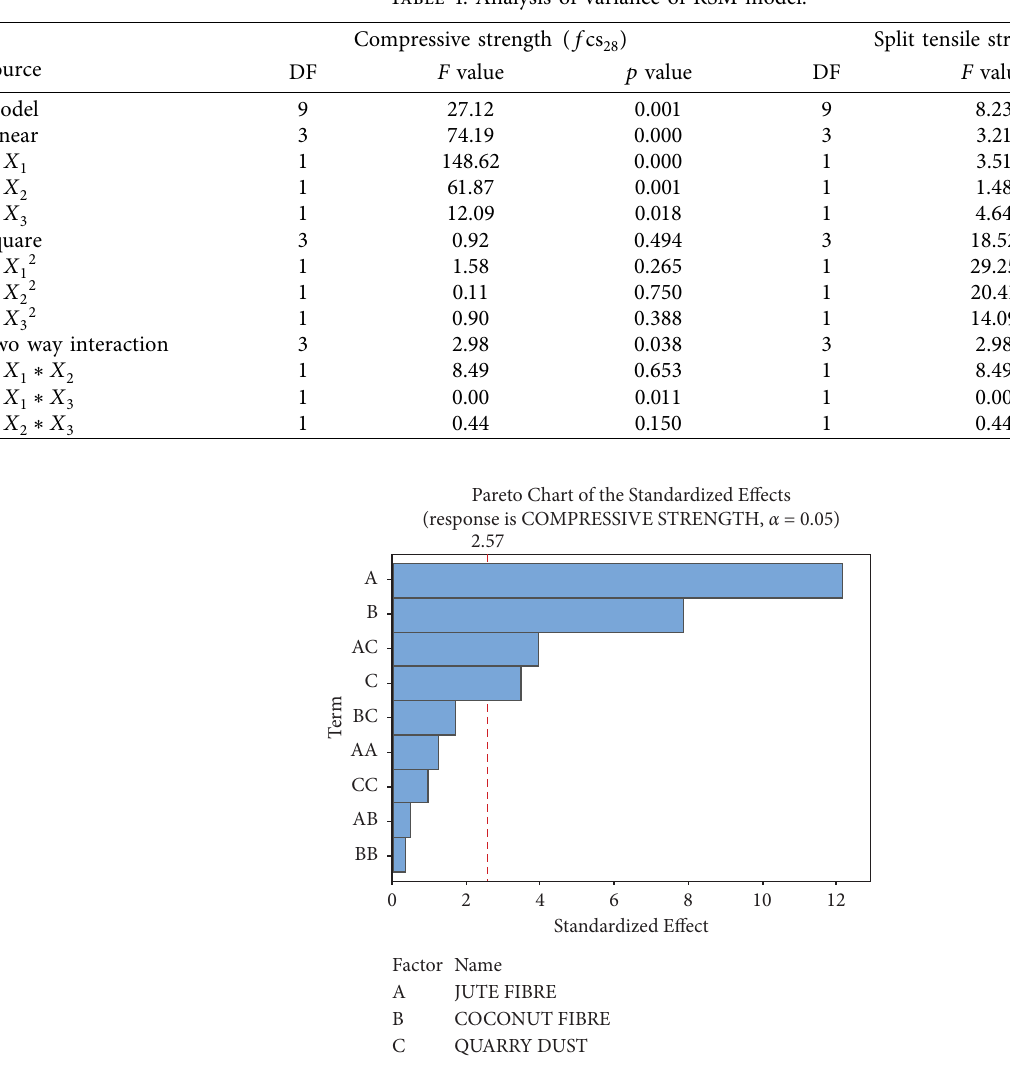
Figure 5: Pareto chart for compressive